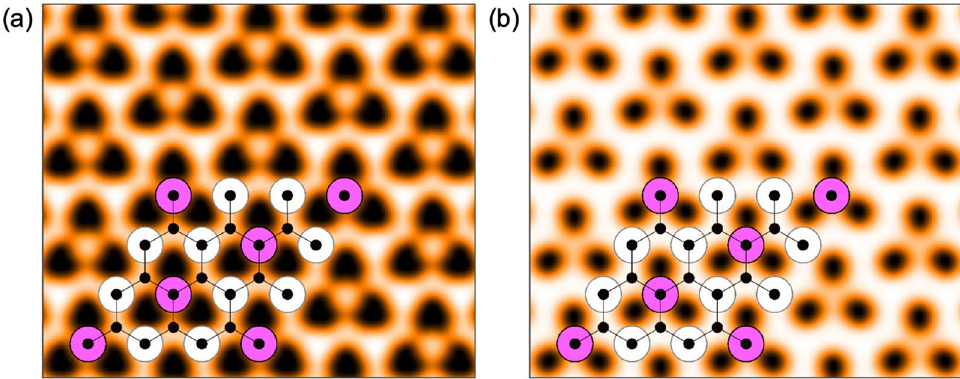
E F 100 meV) states, respectively. The images correspond − = +